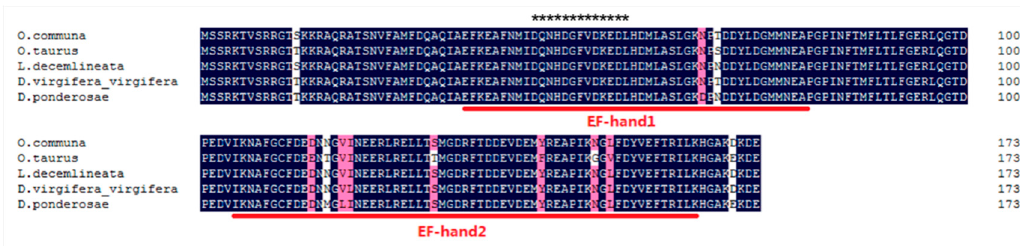
Figure 1. Multiple sequence alignment of myosin regulatory light chain sqh (MRLC-sqh) from O. communa and four other Coleoptera insects. The conserved domains are underlined with red lines and the Ca 2+ -binding sites within the first EF-hand are marked with an “*”. O. communa , Ophraella communa ; O. taurus , Onthophagus taurus ; L. decemlineata , Leptinotarsa decemlineata ; D. virgifera , Diabrotica virgifera ; D. ponderosae , Dendroctonus ponderosae